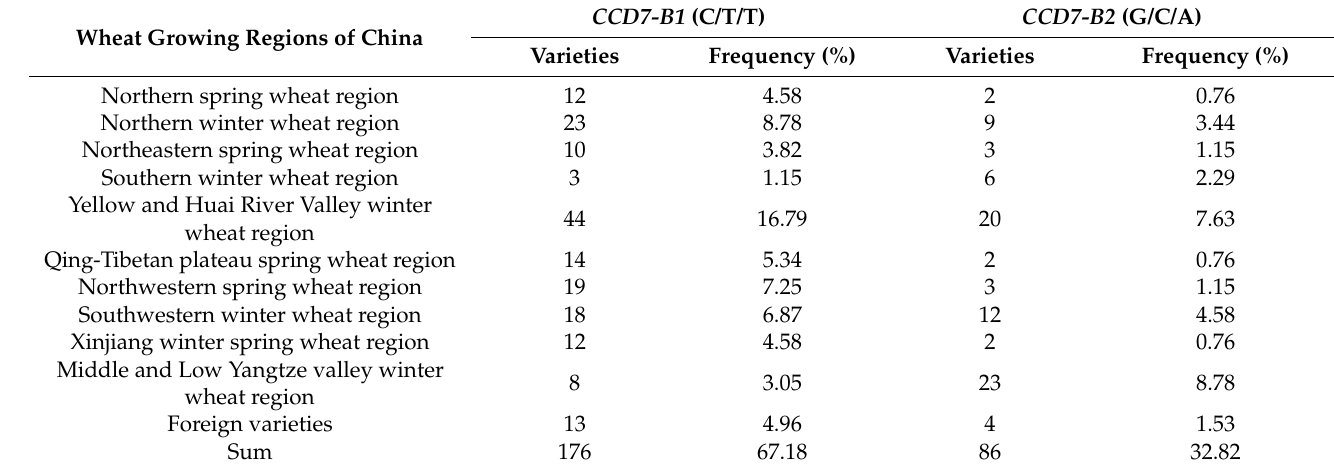
Table 2. The distribution and frequencies of CCD7-B alleles in Chinese wheat micro-core collections. CCD7-B1 (C/T/T) CCD7-B2 (G/C/A) Wheat Growing Regions of China Varieties Frequency (%) Varieties Frequency